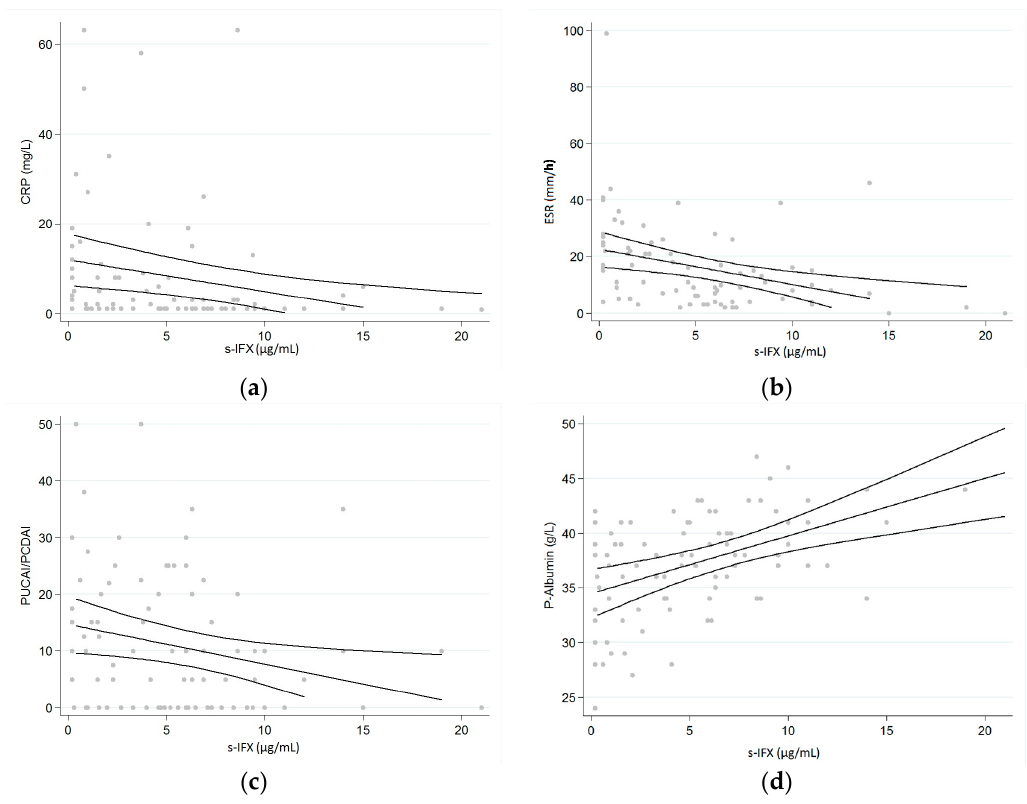
Figure 3. ( a – d ) Serum-IFX is correlated with the disease activity of the patients. S-IFX showed a negative correlation with: ( a ) CRP levels ( p = 0.0084, r 2 = 0.0491); ( b ) s-ESR ( p = 0.0035, r 2 = 0.1388) and ( c ) activity scoring PUCAI and PCDAI ( p = 0.0259, r 2 = 0.0687), and a positive correlation with: ( d ) s-Albumin ( p = 0.0005, r 2 = 0.2182). One outlier of 40 µg/mL was excluded.